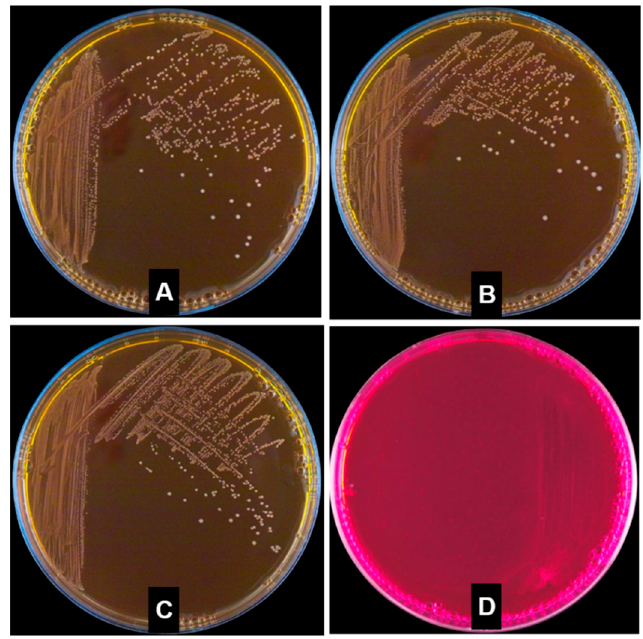
Figure 5. Ammonia production by W. cibaria strains. ( A ) W. cibaria CMU; ( B ) W. cibaria CMS1; ( C ) W. cibaria KCTC 3807; and ( D ) P. vulgaris KCTC 2512.